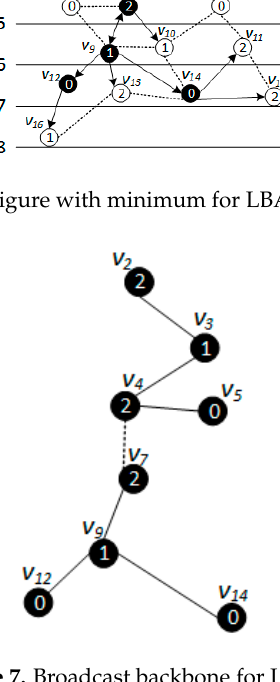
Figure 8. Building covering sub-tree.